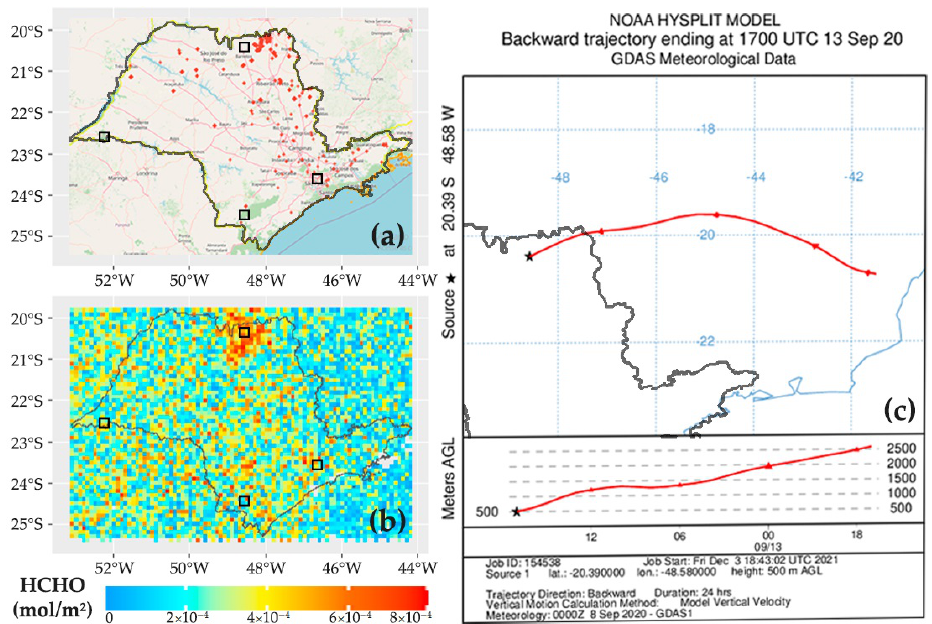
Figure 6. Data for 13 September from ( a ) INPE’S Queimadas Program, where the red dots represent fire outbreaks; ( b ) TROPOMI’s vertical columns of formaldehyde (12 p.m.–4 p.m. local time); and ( c ) HYSPLIT’s backtrajectory of air masses to the NERG area. The black squares indicate the locations of the four areas of interest showed in Figure 2.